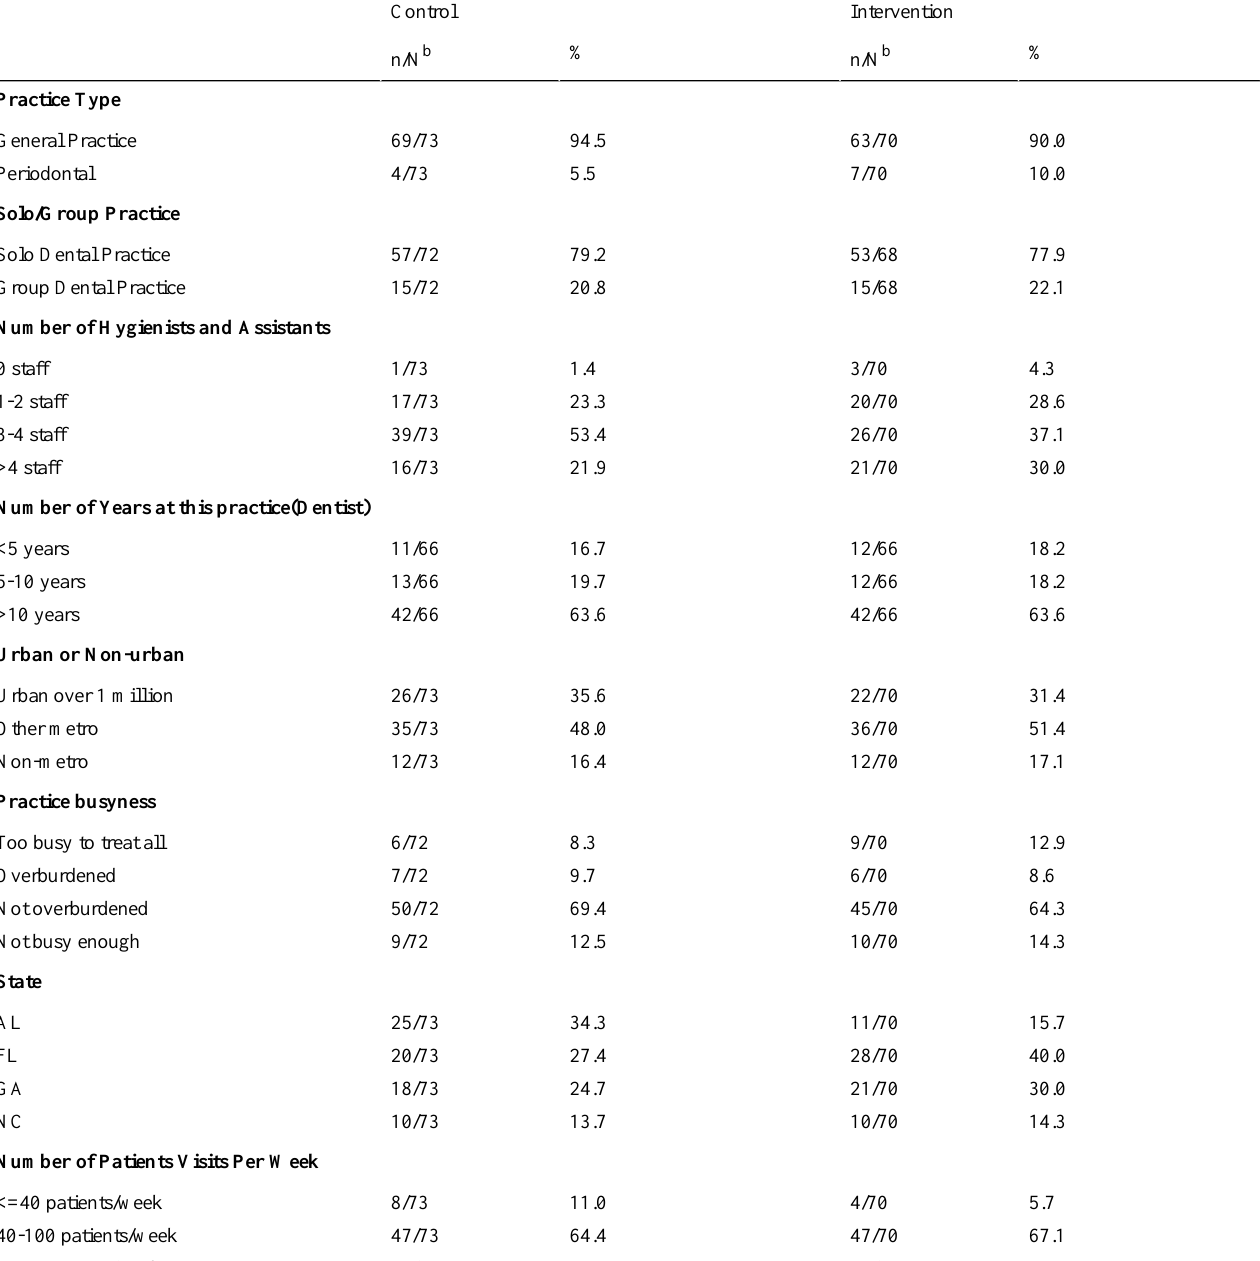
Table 1. Characteristics of 143 dental practices randomized to intervention or control with completed follow-up a